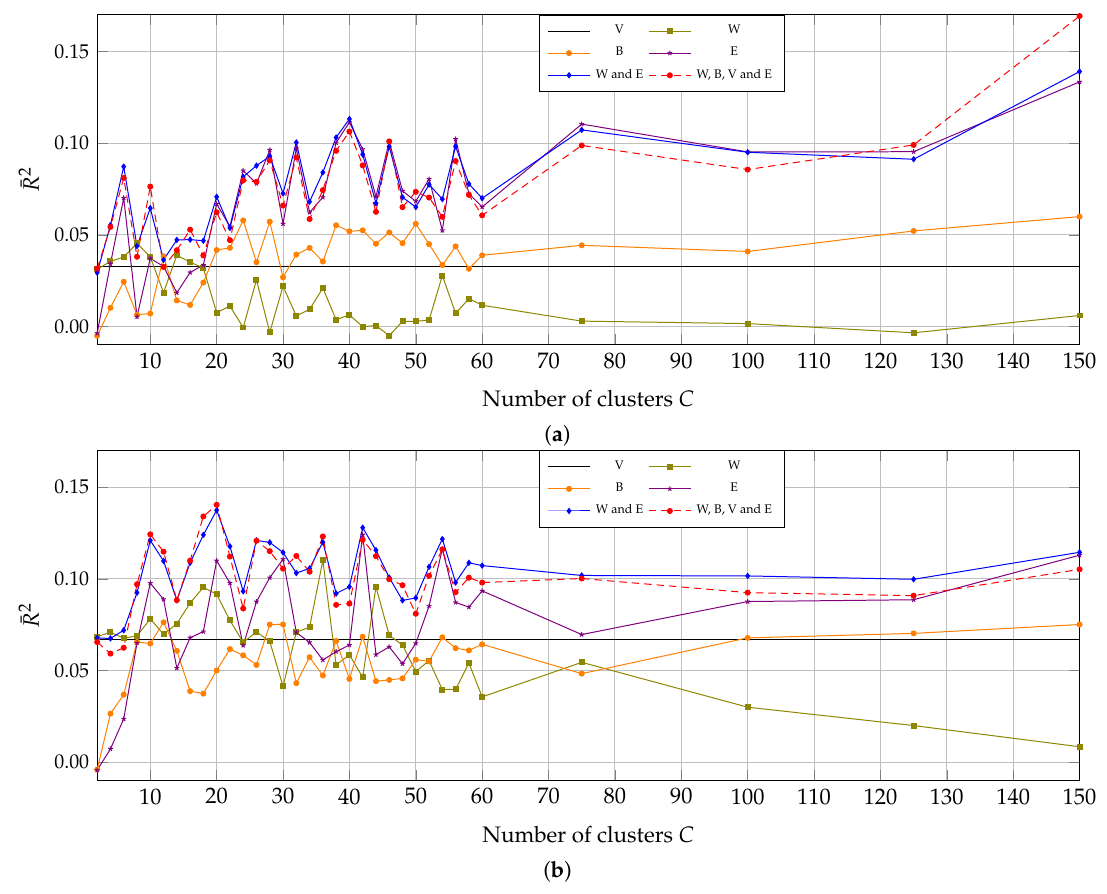
Figure 11. Adjusted coefficient of determination in the multivariate linear regression using one image acquired on ( a ) 30 April and ( b ) 29 June between different combinations of SH measures (V: log-transformed global variability or MDC, W: log-transformed within-class variability, B: log-transformed between-class variability, E: entropy) and the Shannon index (response variable) depending on the number of